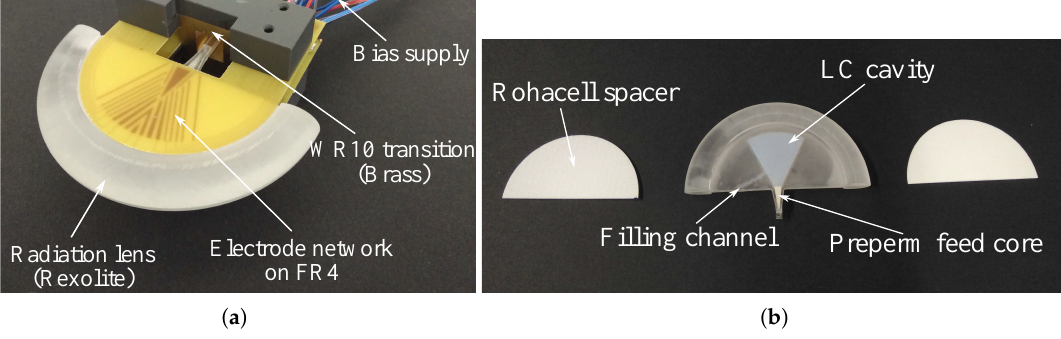
Figure 48. ( a ) Fully assembled dielectric lens antenna demonstrator, ( b ) partly disassembled demonstrator, showing the antenna only. [47], reprinted with kind permission of IEEE.